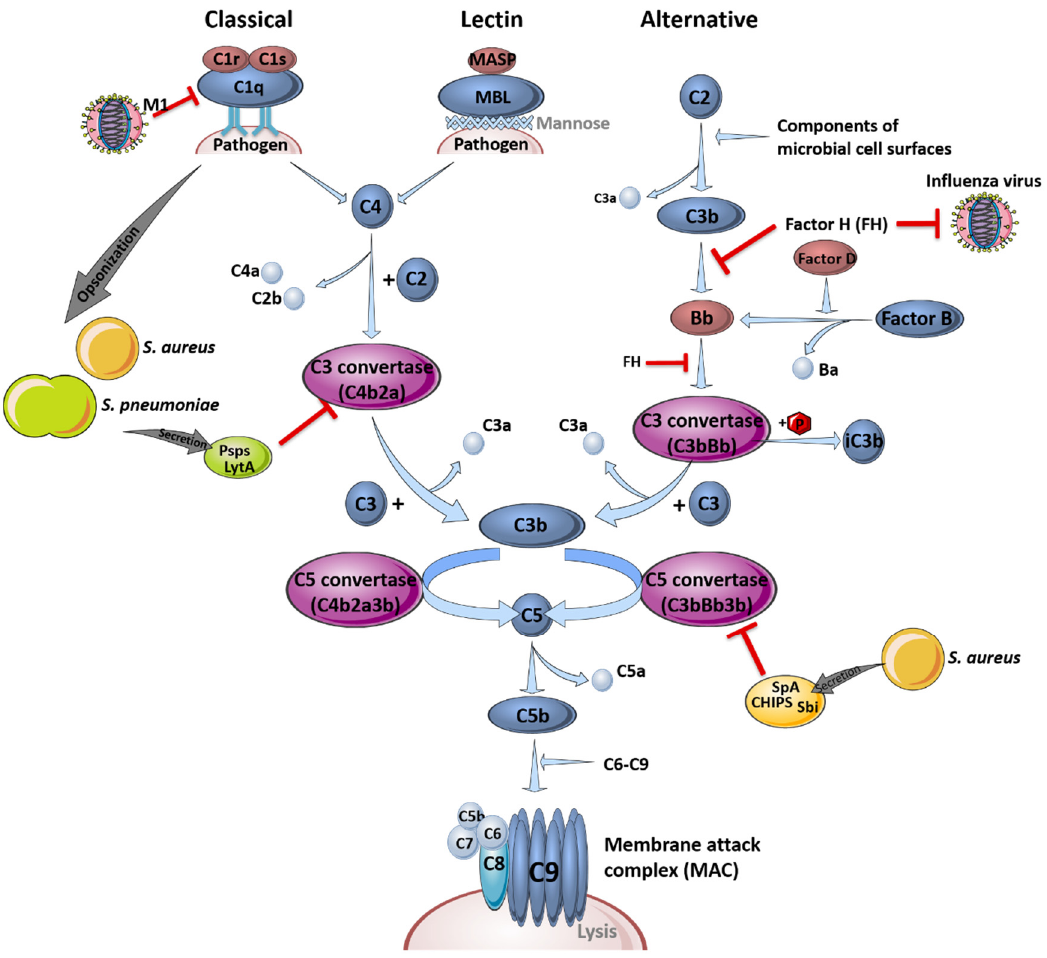
Figure 1. The complement system and its role in pathogen clearance. Schematic overview of the activation of the classical, the lectin and the alternative signaling pathway, leading to the formation of the membrane attack complex (MAC). Interference of the different pathogens with the complement system pathways is indicated by red inhibition arrows. This figure was created using Servier Medical Art templates, which are licensed under a Creative Commons Attribution 3.0 Unported License; https://smart.servier.com (accessed on 11 February 2021).